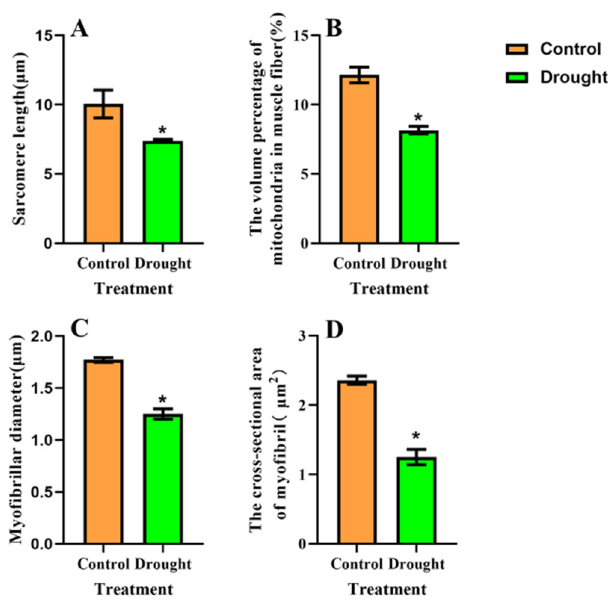
Figure 6. Changes in flight muscles of BPH adult females fed on drought-stressed and non-stressed rice: ( A ) sarcomere length; ( B ) percentage of mitochondrial volume in flight muscle fibers; ( C ) changes in the diameter of myofibrils; and ( D ) changes in the cross-sectional area of myofibrils. * represents significant differences at p < 0.05 ( PLSD